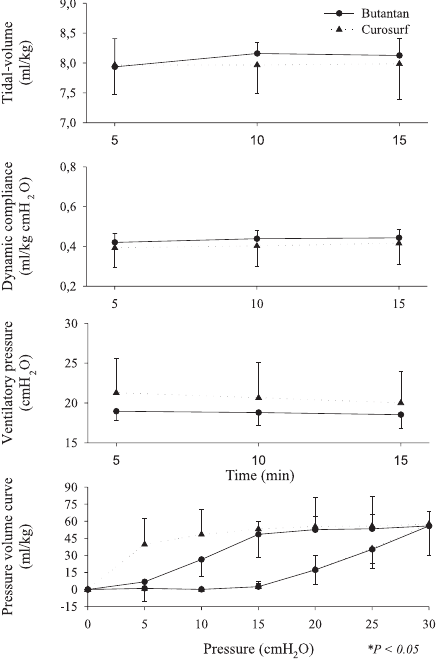
Figure 4 - Time point 2 (30 days after being kept at 20 o C-water bath temperature before being warmed to 37 o C for 5 minutes) data for tidal- volume (V ), dynamic compliance (DC), ventilatory pressure (VP), and t pressure-volume curve (mean ± SD). Data were analyzed by the Student t test (parametric data) or Mann-Whitney test (nonparametric data).